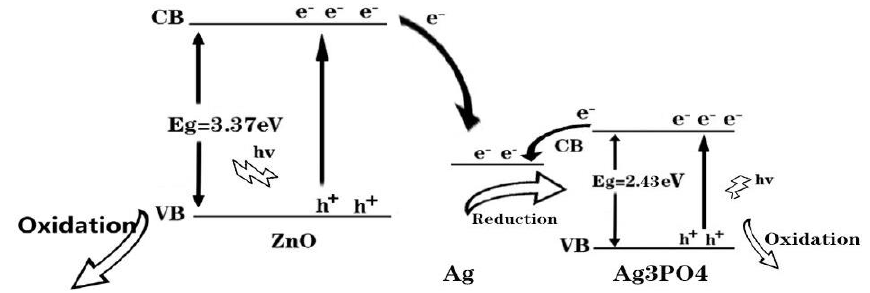
Figure 9. Schematic representation of the ZnO@Ag@Ag 3 PO 4 heterojunction.